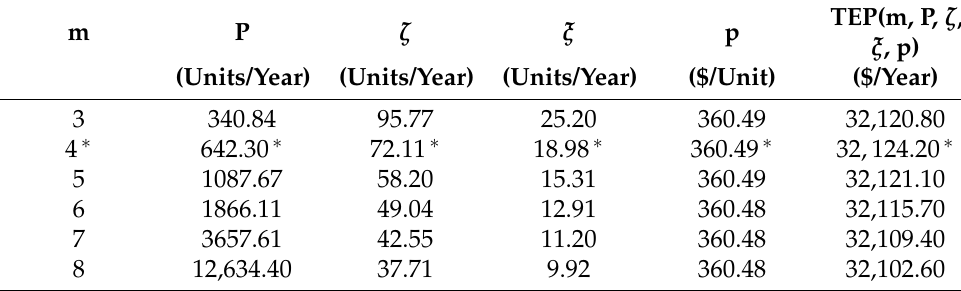
Table 2. Number of consignments for the optimum solution.